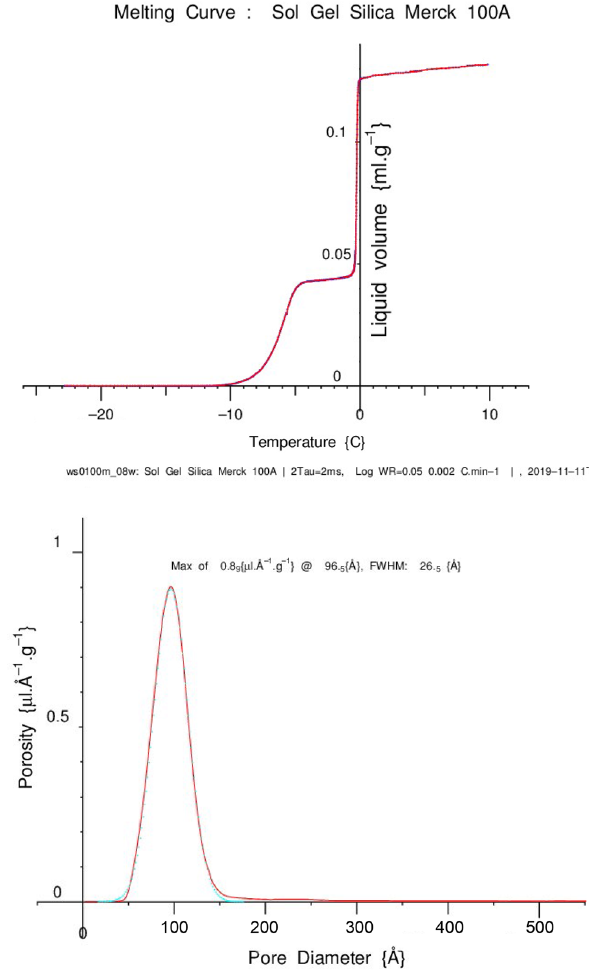
Fig. 20 a) Melting point curve. b) NMRC pore-size distribution, for a nominal 100 Å pore diameter porous